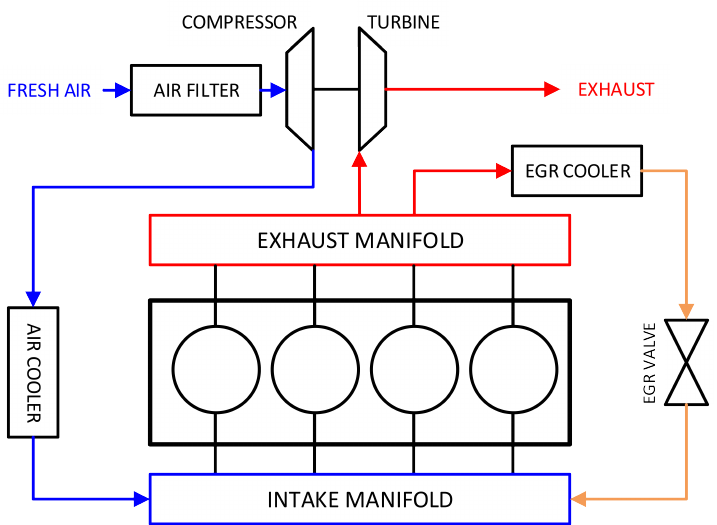
Figure 1. Engine architecture with air-path